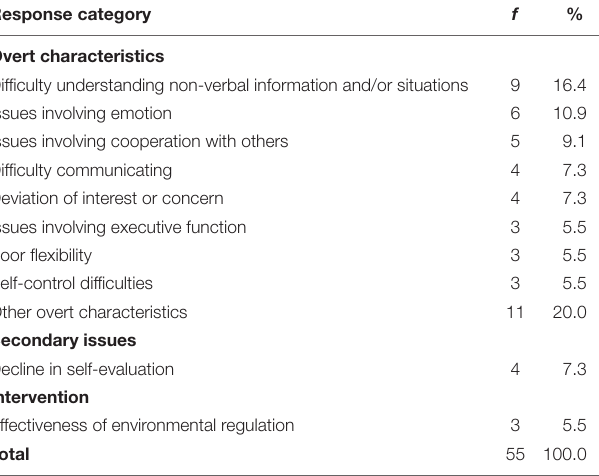
TABLE 2 | Psychological similarities between ADHD and ASD ( N =